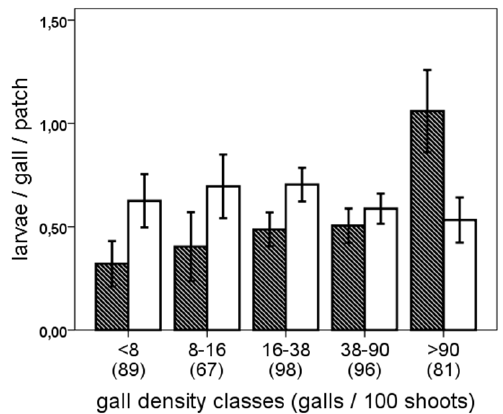
Figure 6. The influence of gall density / thistle patch (= galls / 100 thistle shoots) on E. ser- ratulae (black) and E. robusta (white). (In parentheses: number of galls